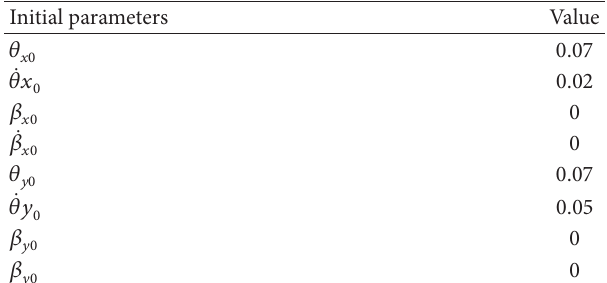
Table 4: Initial conditions.